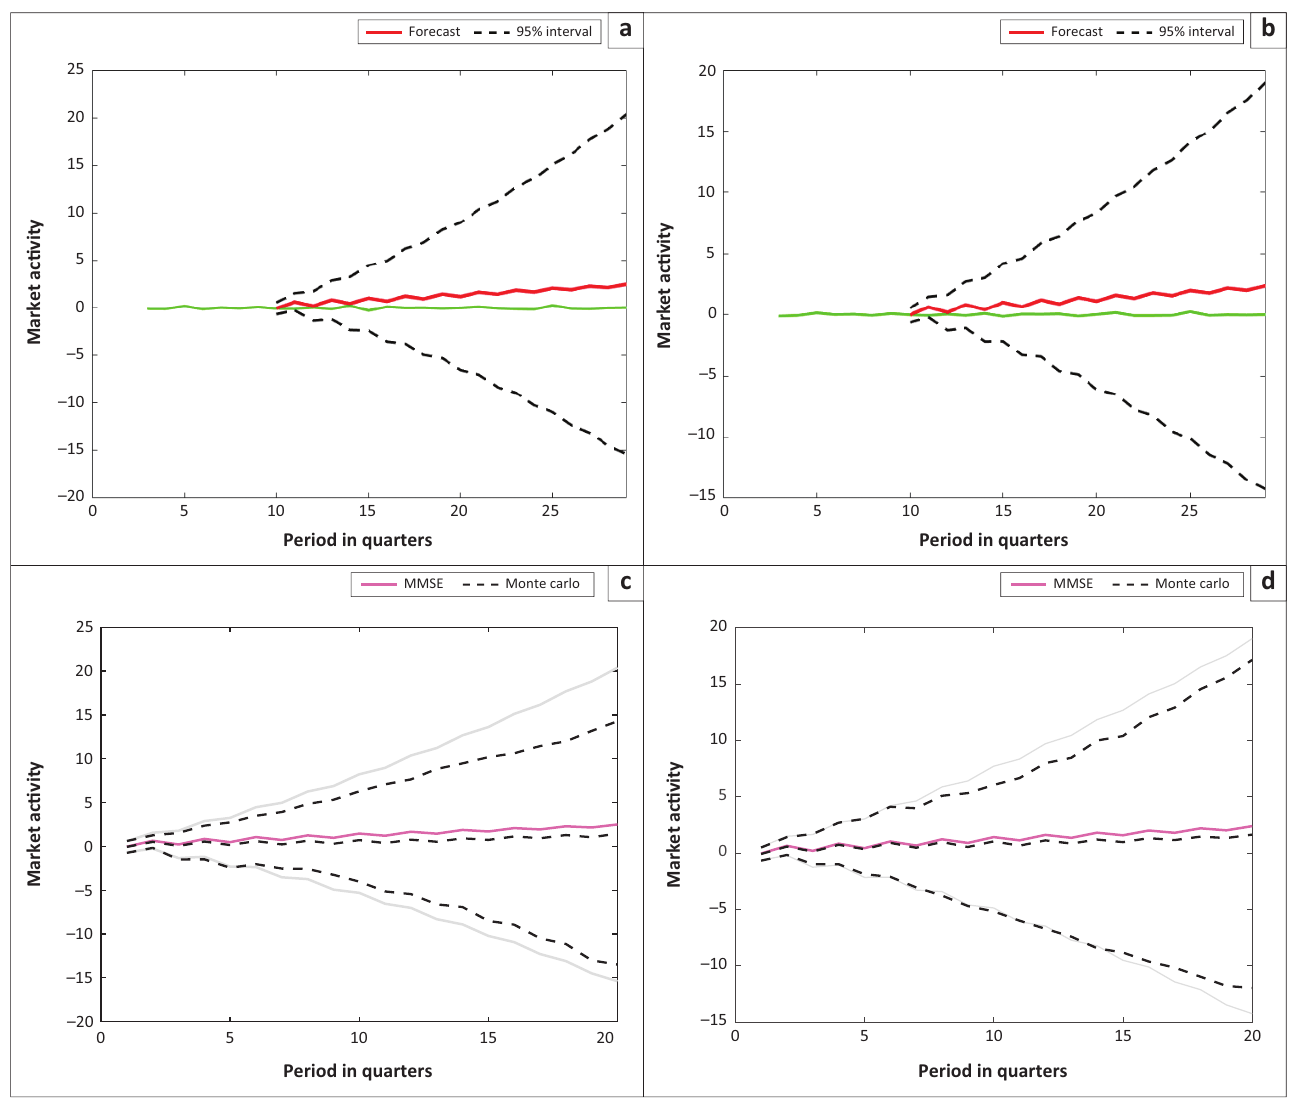
FIGURE 6: Applying a Monte Carlo analysis to the Global Art Price Index (API) in United States Dollars and European Euros and examining the degree of market volatility and returns using quarterly data from 1998 to 2020. (a) API US forecast and 95% forecast interval, (b), API EU forecast and 95% forecast interval, (c) API US Monte Carlo and a minimum mean square error (MMSE) and Monte Carlo forecasts and (d) API EU MMSE and Monte Carlo